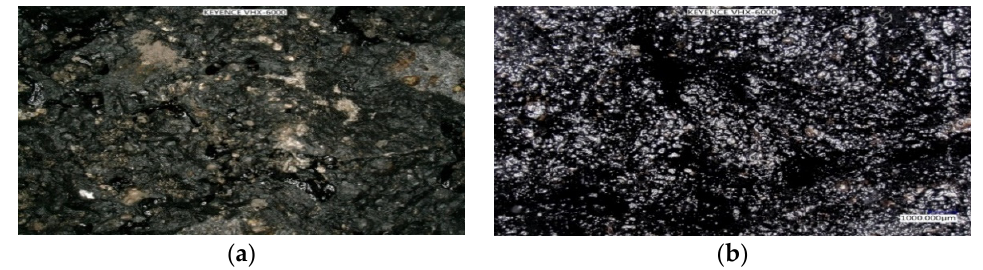
Figure 10. Granulate-based pavement surface in microscopic image ( a ) without rejuvenator—image